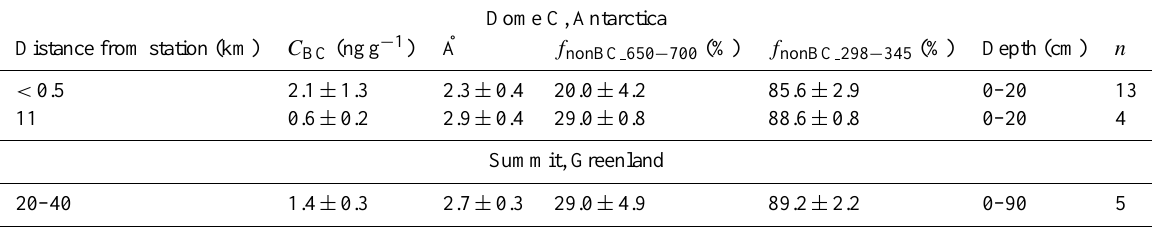
Table 1. Description of snow samples collected near Dome C, Antarctica, in January 2004 and Summit, Greenland, in June 2007. The average and standard deviation (1 σ ) of black carbon concentration ( C BC ), the Angstrom exponent ( ˚A), the mean fraction of nonBC ( f nonBC ) absorption in the λ = 650–700nm and λ = 298–345nm ranges, the snow depths over which these samples were collected, and the number of snow samples ( n ) collected at each location are provided. Please see Appendix B for more information about each sample collected. Dome C, Antarctica Distance from station (km)